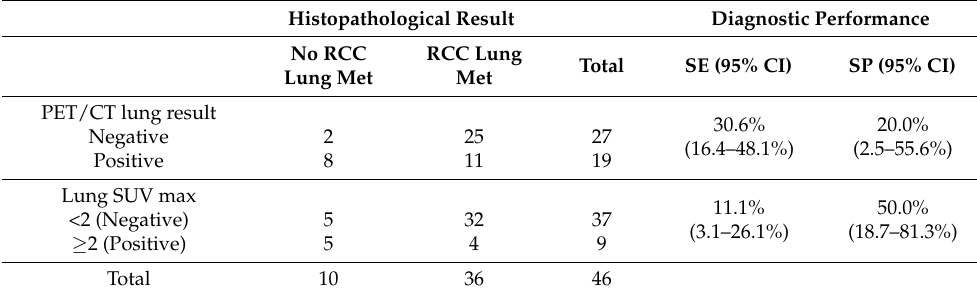
Table 4. Lesion classification and diagnostic performance of the PET/CT lung results and lung SUV max, with the histopathological result as the gold standard to define a lesion as an RCC lung metastasis, among lesions with size ≤ 10 mm ( n = 46).